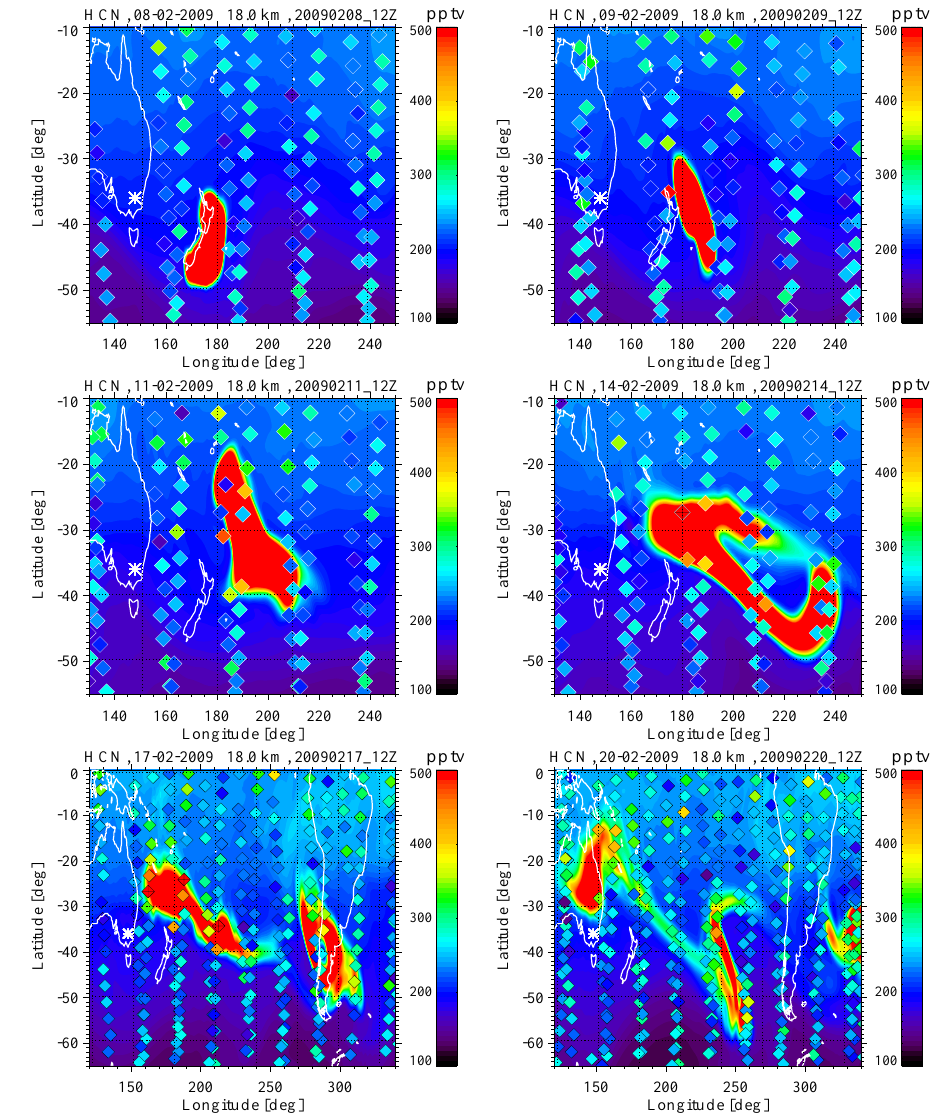
Fig. 7. Measured and modelled HCN at 18km altitude. Model distributions are smoothed vertically and along-track to MIPAS resolution. Note the different map section for the bottom panel. For more details see Fig.